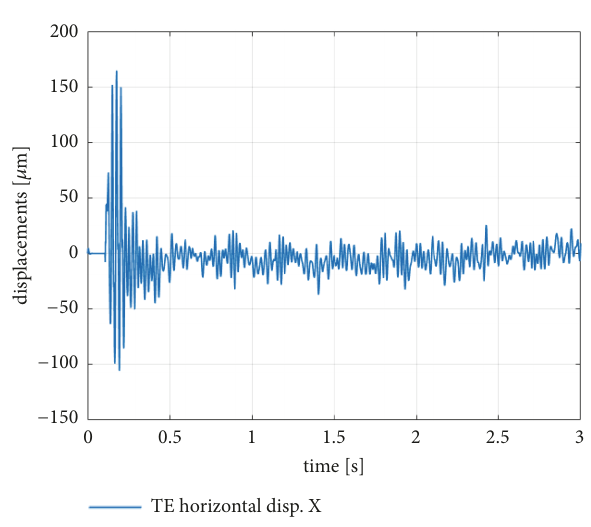
Figure 14: Predicted rotor horizontal displacements during a landing test (DE node).